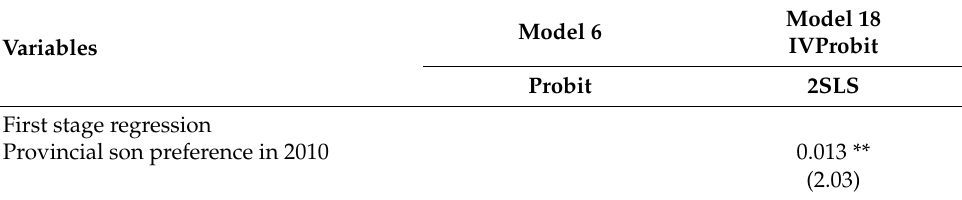
Table 7. Endogenous analysis of the influence of having sons on migrant women’s overwork.